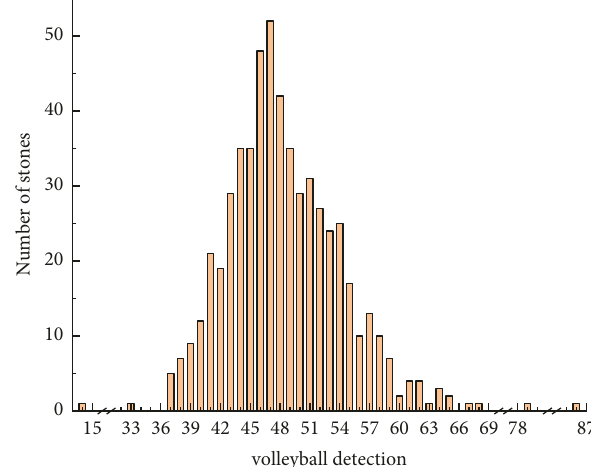
Figure 4: Distribution of eigenvalues of rock material